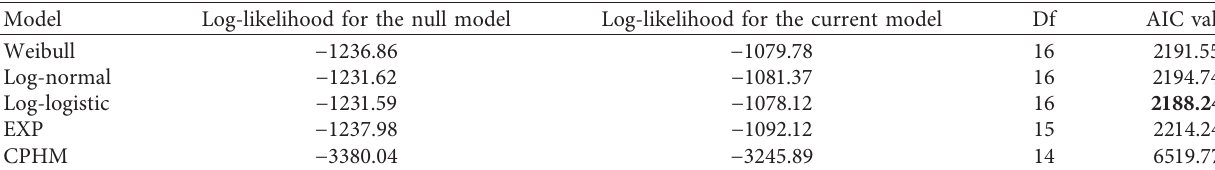
Table 4: Summary of AIC and BIC values for different survival